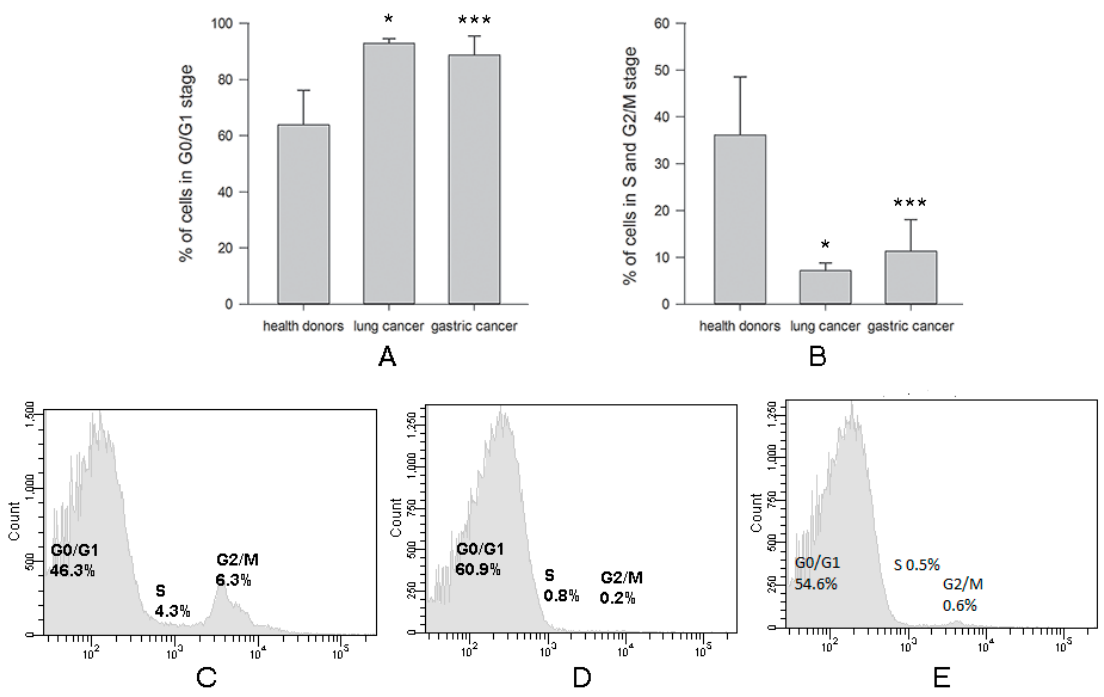
Figure 4. Differences in % NK cells in cell cycle phases harvested from healthy donors and cancer patients. NK cells were isolated from the peripheral blood samples by negative selection using Dynabeads. Cell cycle was determined as described in M&M. ( A ) Data of % NK cells in G0/G1 stage are shown as the mean ± SEM (ANOVA). ( B ) Data of % NK cells in S and G2/M stage are shown as the mean ± SEM (ANOVA). ( C ) Cell cycle of NK cells from one of 10 representative healthy donors. ( D ) Cell cycle of NK cells from one of 7 representative patients with lung cancer. ( E ) Cell cycle of NK cells from one of 12 representative patients with gastric cancer. (* p < 0.05 and *** p < 0.001).